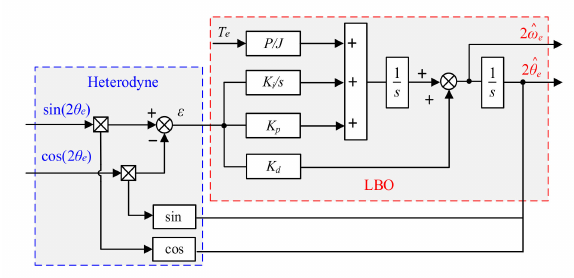
Figure 7. Overall block diagram of the position